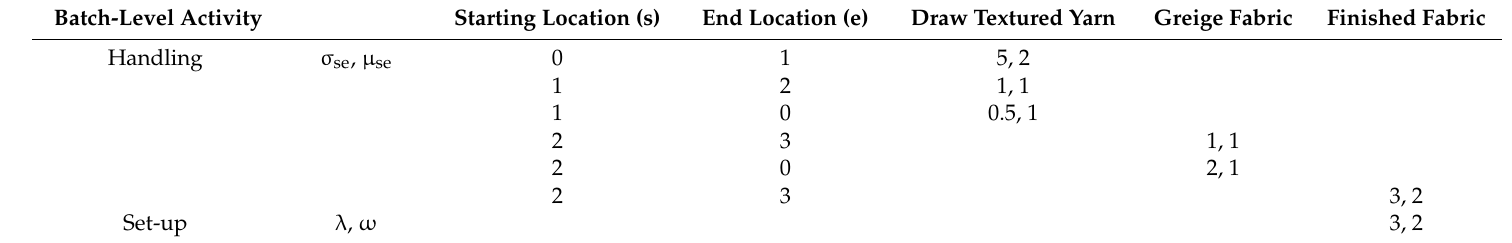
Table 2. Example data for batch-level